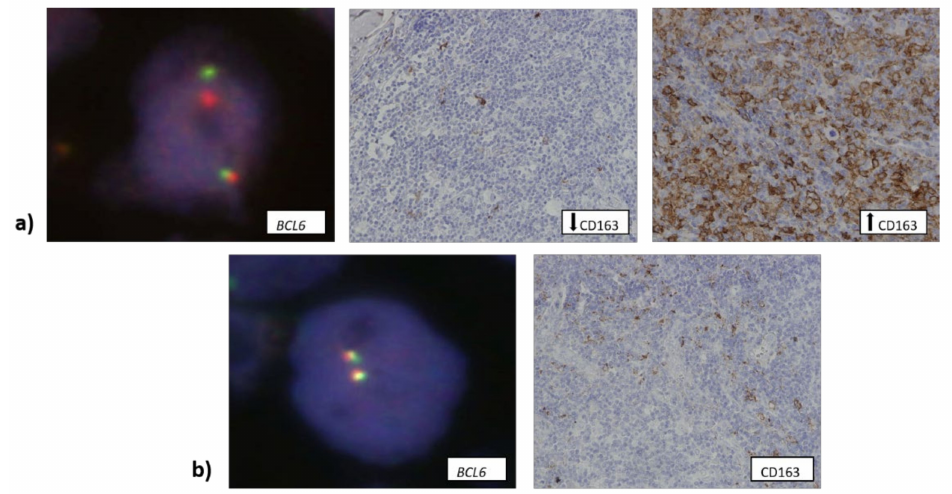
Figure 5. ( a ) Samples that contained a low or a high number of CD163+ cells (400 × total magnification) showed BCL6 aberration (shown as split-apart signal, 1000 × total magnification). ( b ) Samples that contained an intermediate number of CD163+ macrophages (400 × total magnification) showed BCL6 translocation significantly less often (1000 × total magnification). Down arrow: low number of CD163+ macrophages (less than 5% of the overall number of cells within the tumor tissue); up arrow: high number of CD163+ macrophages (over 25% of the overall number of cells within the tumor tissue).